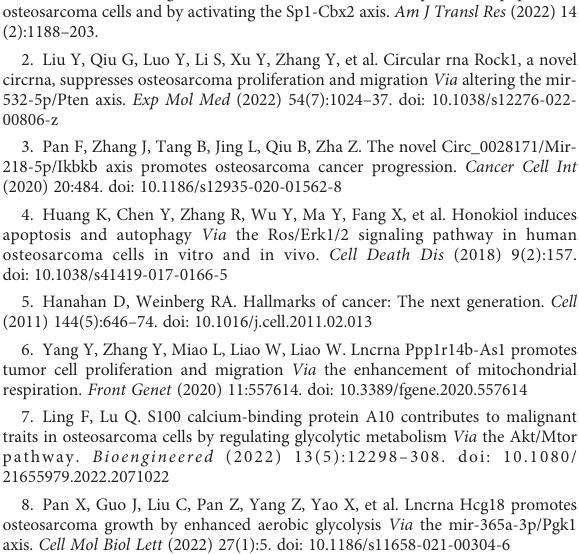
SUPPLEMENTARY FIGURE 1 The 13 drugs were selected for osteosarcoma patients with the low- risk group